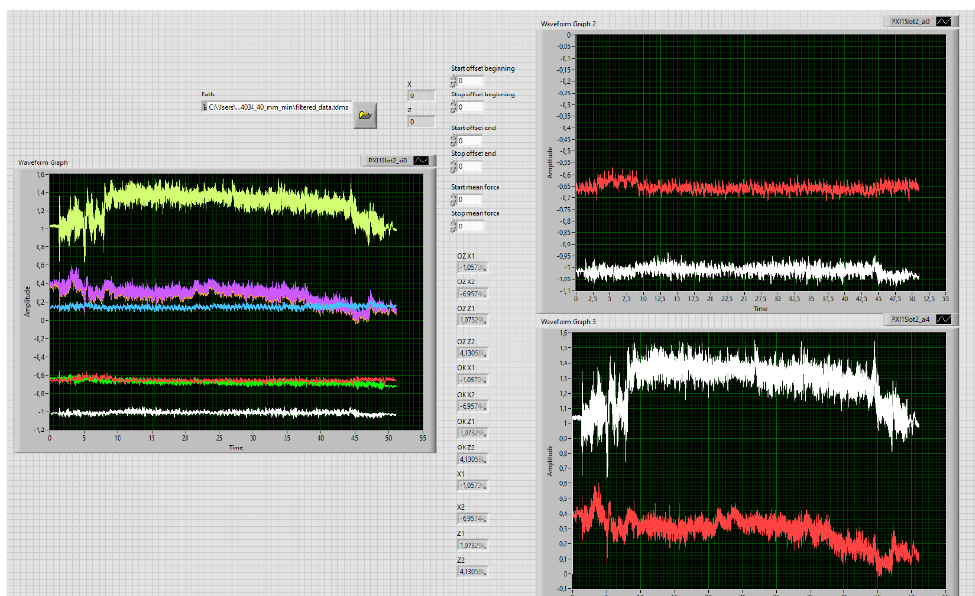
Figure 2. Experimental setup.